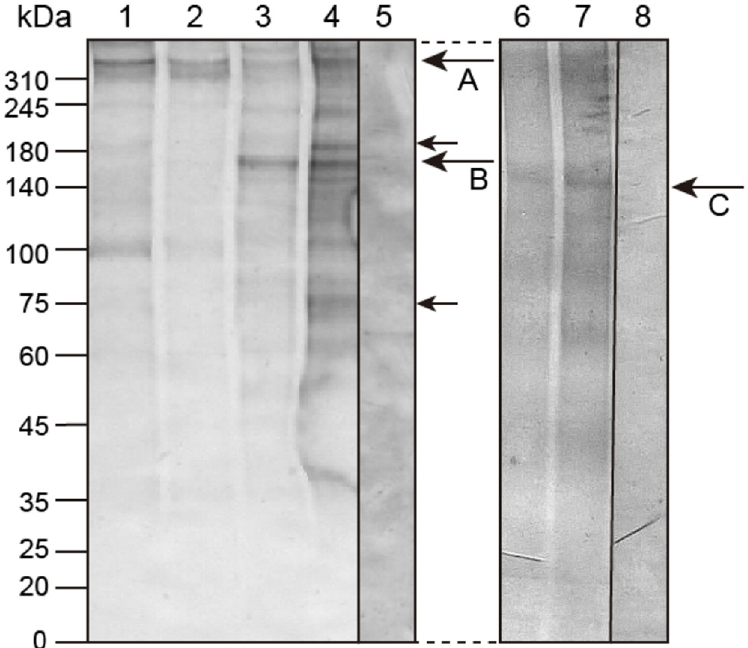
Figure 1. Hp-Htt expression during early development by immunoblotting. Lysates of embryos at the sBL stage (lane 1), the pL stage (lane 2), the 2aPL stage (lane 3), and the 4aPL stage (lane 4) were probed with anti-Hp-Htt Ab. For the negative control, 4aPL lysate was probed with a rabbit pre-immune serum (lane 5). An Ab-positive band was detected at around the 350 kDa region at the sBL and pL stages (arrow A). In 2aPL a new smaller band at the 165 kDa region was detected (Arrow B). In 4aPL, a further two new smaller bands (small arrows at 192 kDa and 75 kDa regions) appeared, in addition to the initial 165 kDa band. Anti-Hp-Tjp1-antibody detected the protein expression pattern of the pL stage (lane 6) and the 4aPL stage (lane 7). A single Ab-binding band was detected at the 150kDa region (Arrow C). The lysate was probed with a rabbit pre-immune serum (lane